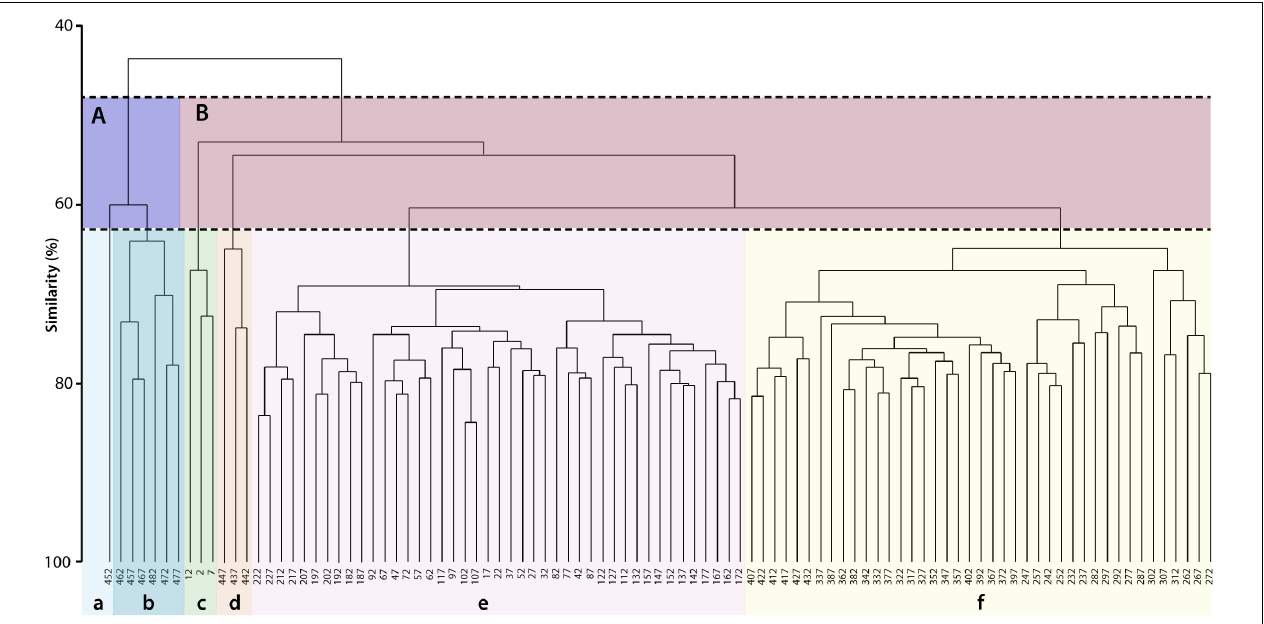
FIGURE 4 | Hierarchical cluster analysis obtained from the benthic foraminifera Bray-Curtis similarity matrix. Benthic foraminifera abundances were root transformed. Two clusters are distinguished at 47% similarity (A,B) . At a higher similarity level (62%), the cluster analysis allows to isolate 5 clusters and one outlier sample. Each cluster corresponds to a specific benthic foraminiferal assemblage. The species contributing the most to the similarity among and the dissimilarity between clusters are given in Tables 3 – 6 . TABLE 3 | List of the 5 most contributing species to the similarity within clusters A and B, which separate at 47% similarity on the hierarchical cluster analysis ( Figure 5 ). Cluster A Average similarity: